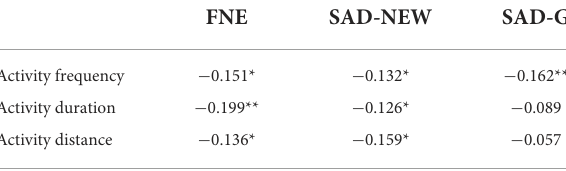
TABLE 6 Correlation results of social anxiety and children’s